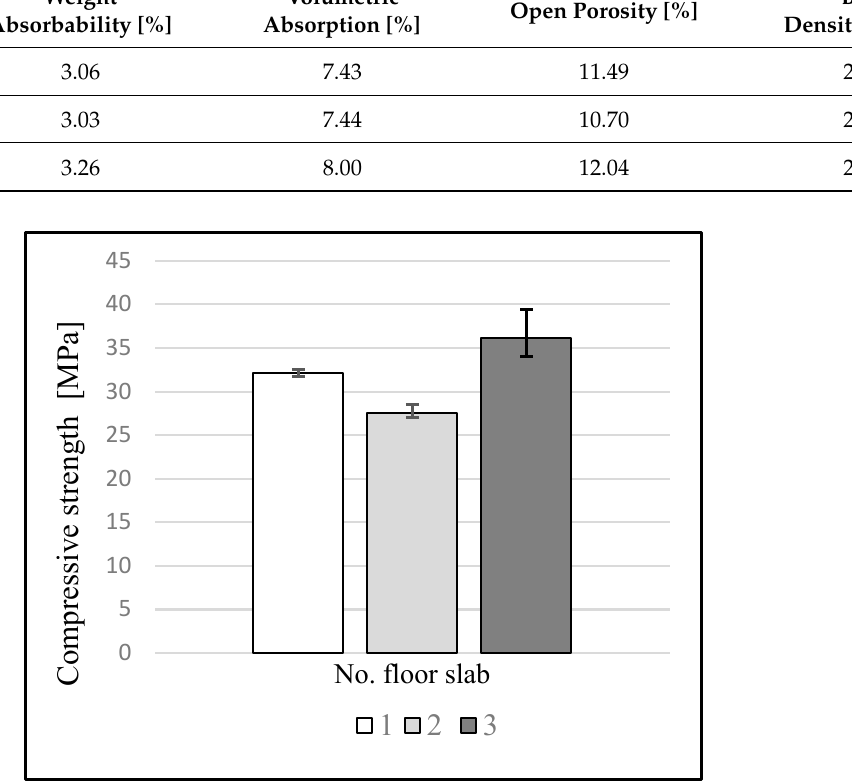
Figure 12. The average compressive strength of the concrete from each floor. The error bars indicate the maximum and minimum values in the floor slabs.